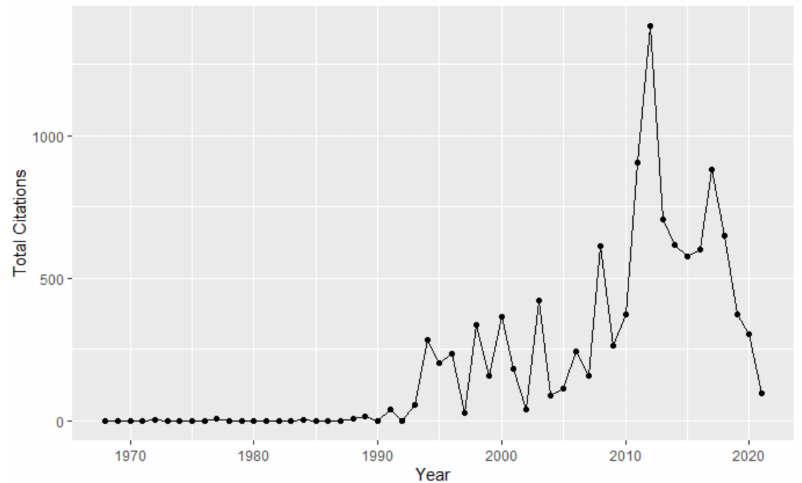
Figure 2. Total citations from 1968 to 2021.